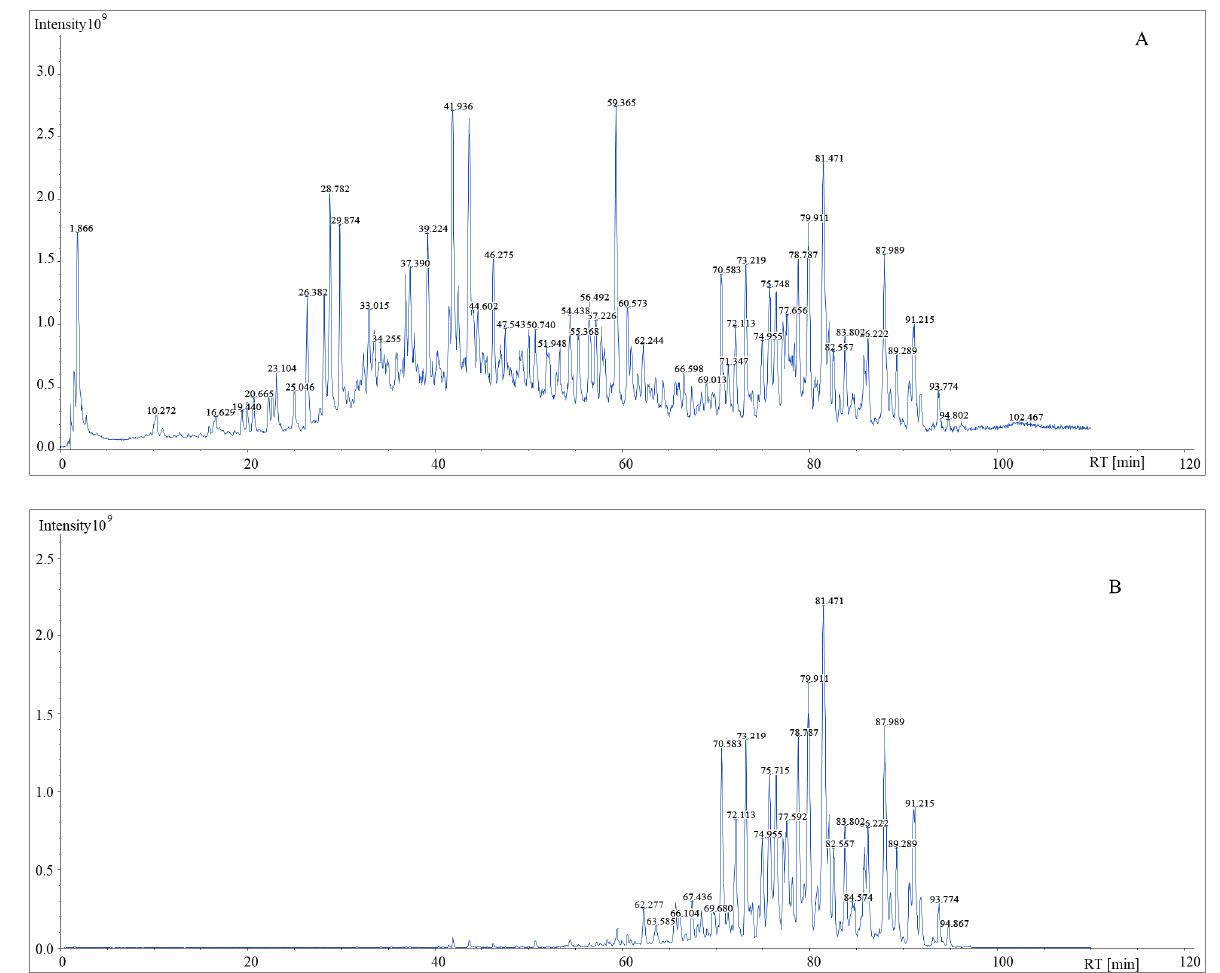
Figure 4. The TIC chromatogram of Convolvulus scammonia without filtration ( A ) and with MDF filtration ( B ).